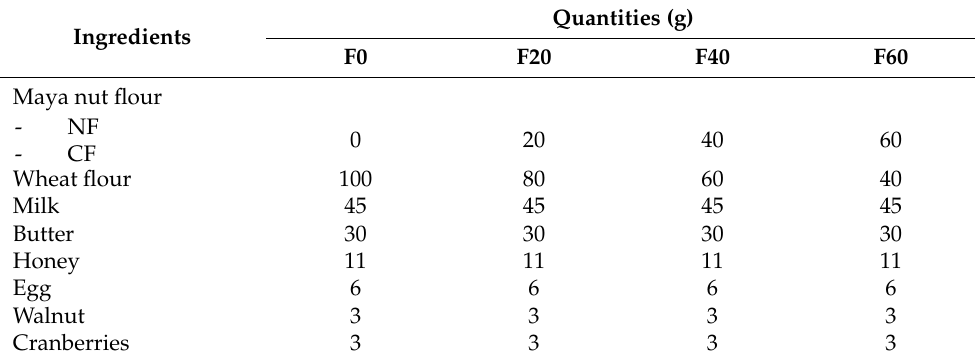
Table 1. Formulation of two types of Maya nut cookies with commercial flour (CF) and naturally